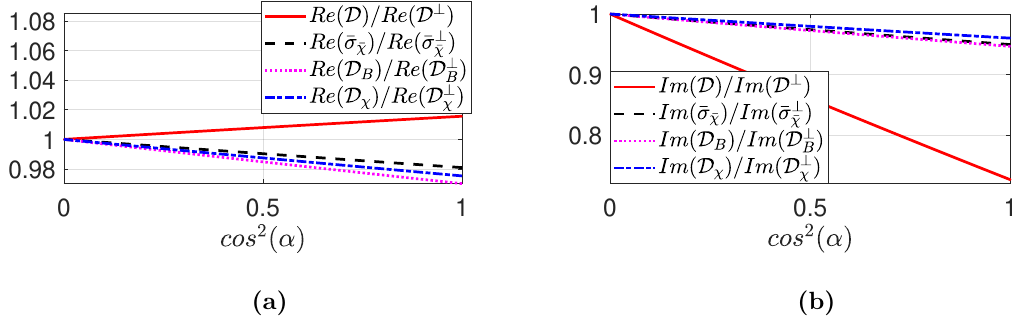
Figure 9. Normalised TCFs as functions of cos 2 ( (cid:11) ) when (cid:20) B = 0 : 5 and ! = q 2 = 0 : 1.